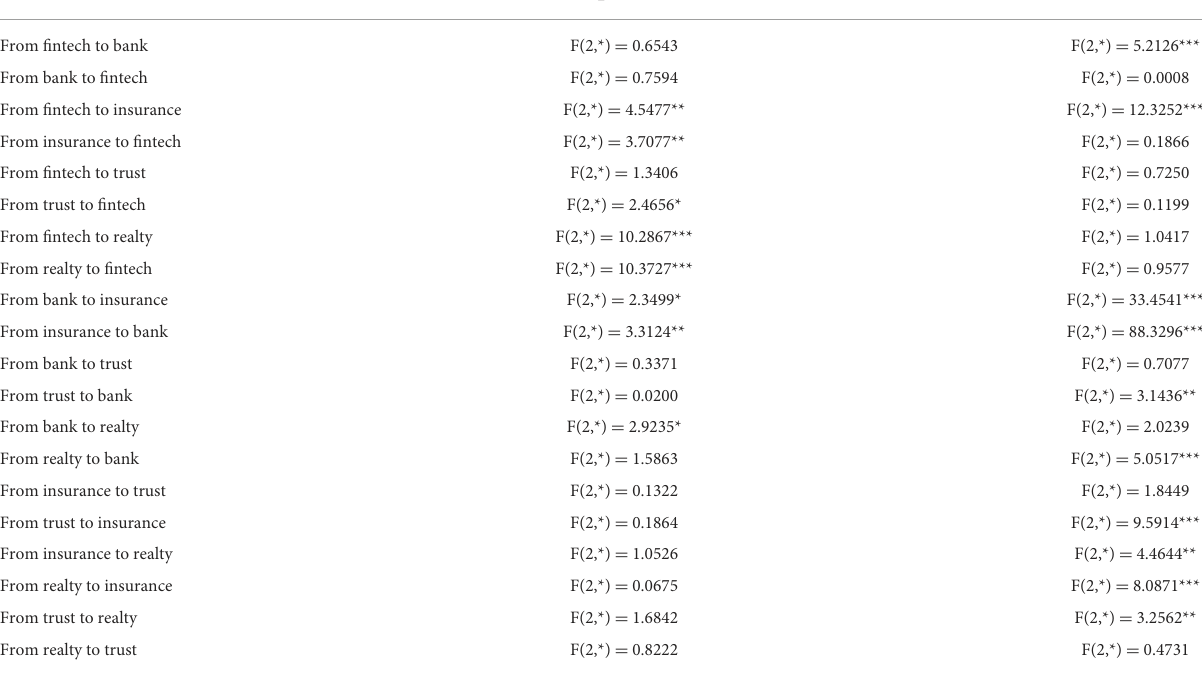
TABLE 6 Risk spillover in pairs in the system.